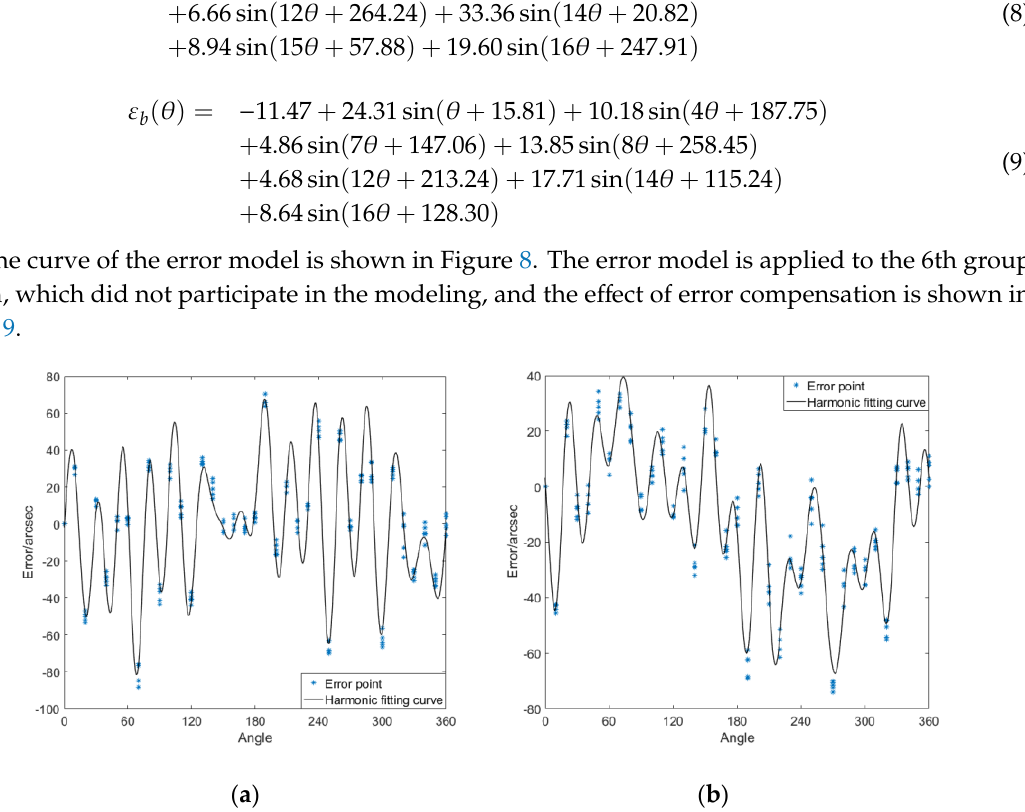
Figure 8. Curve of the angle error model and error scatter diagram: ( a ) joint module a; ( b ) joint module b.